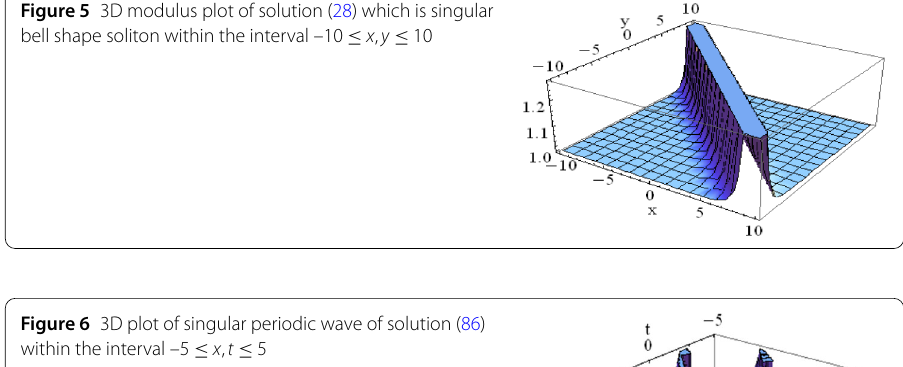
Figure 6 3D plot of singular periodic wave of solution (86) within the interval –5 ≤ x , t ≤ 5